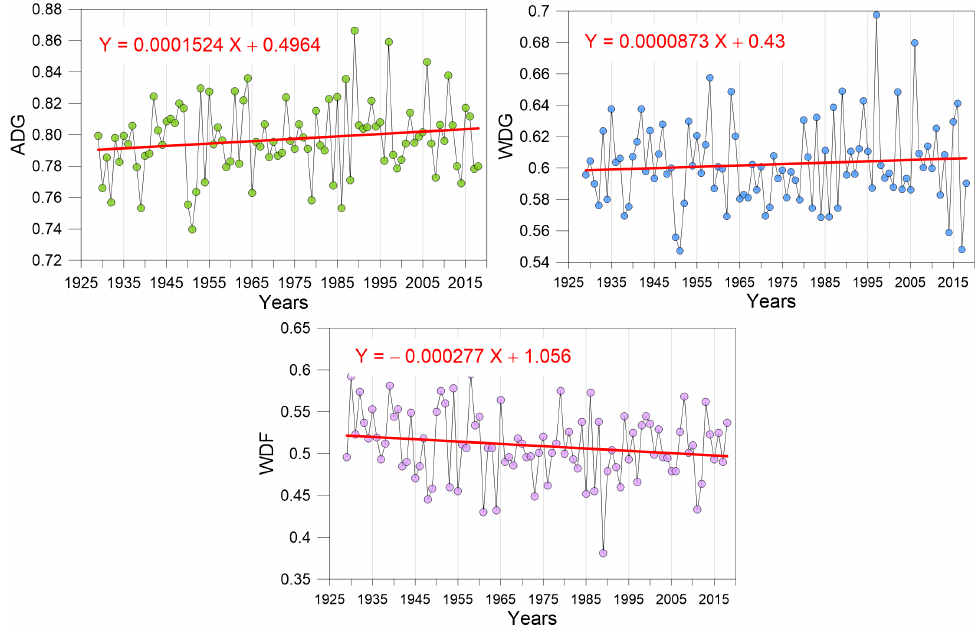
Figure 7. Graphical representation of Wet-Day Frequency Index ( WDF ), Annual-Day Gini index ( ADG ), and Wet-Day Gini index series ( WDG ), with the equations of regression lines.